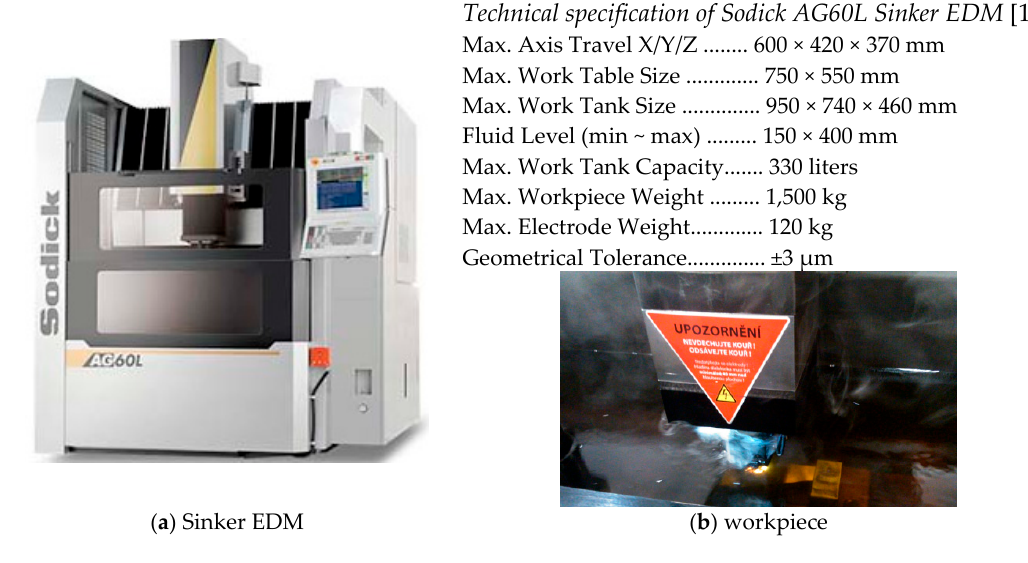
Figure 1. CNC Sodick AG60L Sinker EDM.